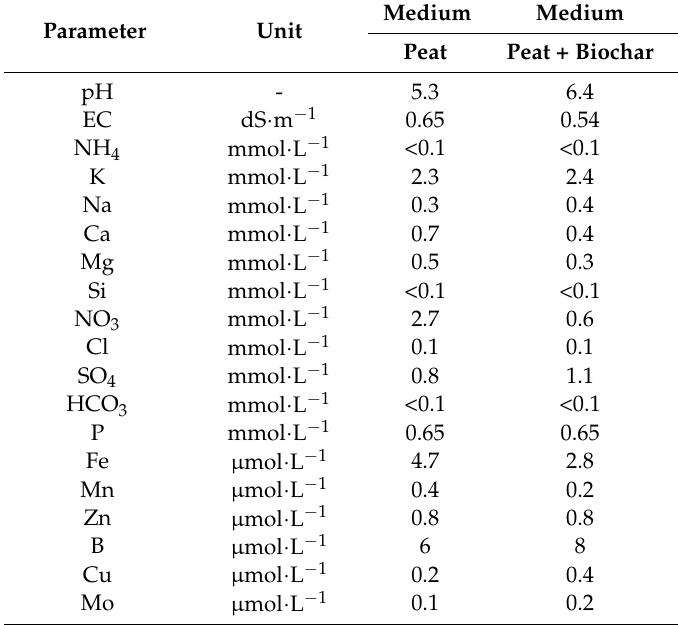
Table 6. Nutrient concentrations at the end of the cultivation period, including pH and EC of peat and peat with 20% v/v biochar 1